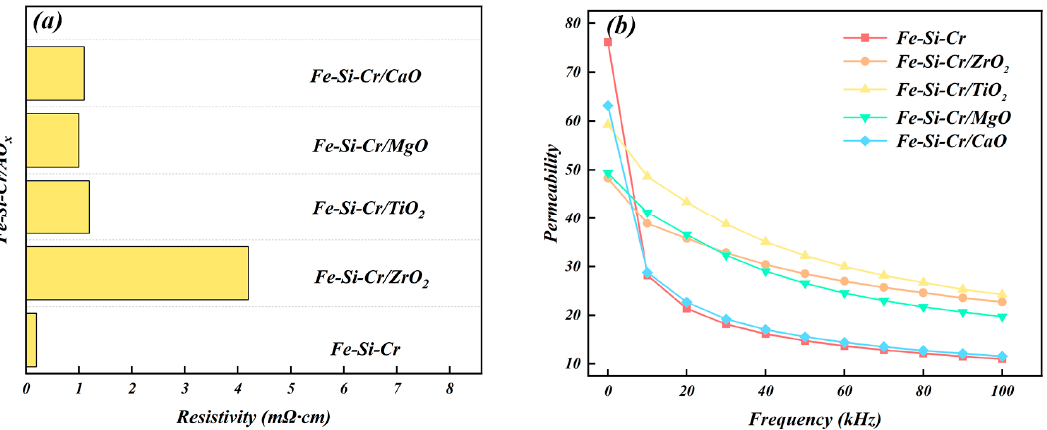
Figure 6. ( a ) Resistivity and ( b ) permeability of the Fe-Si-Cr soft magnetic core and Fe-Si-Cr/AO x soft magnetic composite cores. soft magnetic composite